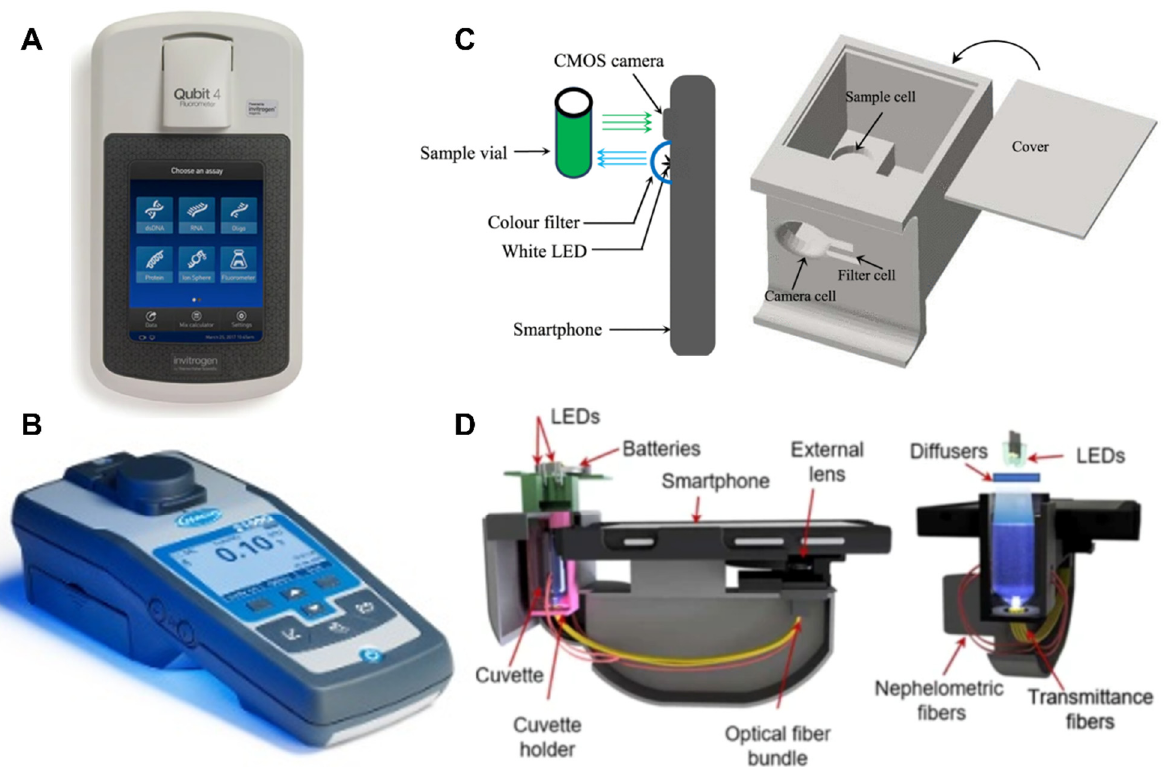
Figure 4. Leading detection devices. ( A ) Thermo Fisher Scientific Qubit™ 4 Fluorometer. Reprinted